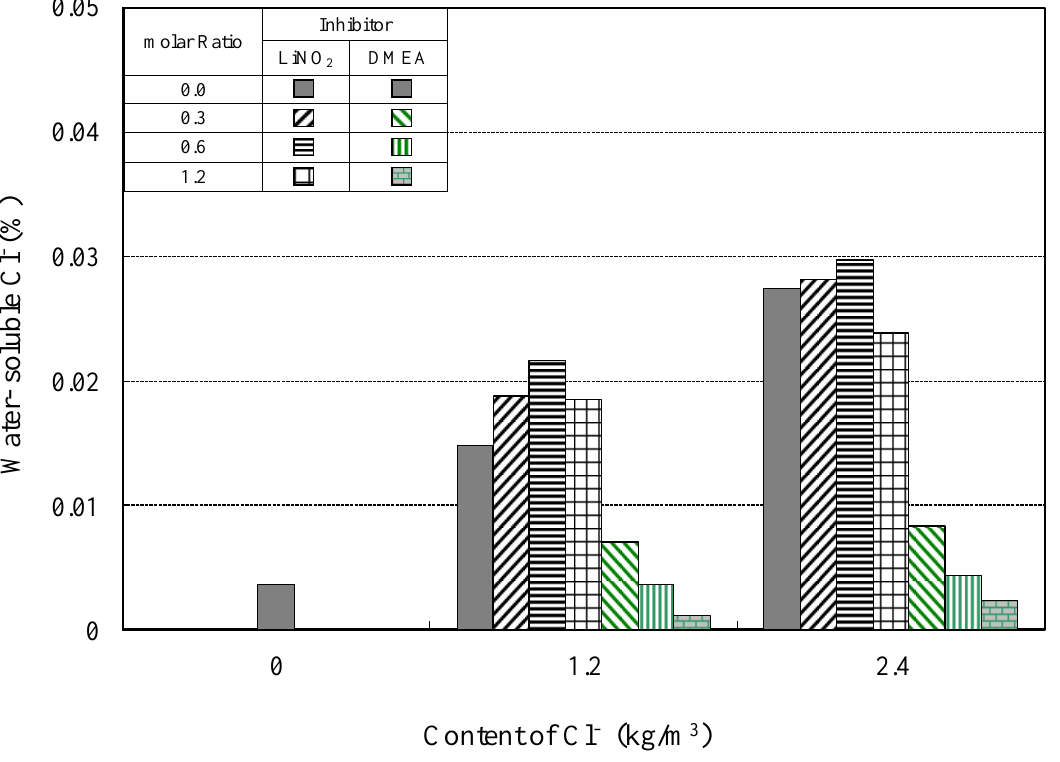
Figure 13. Relationship between water-soluble chloride content and content of Cl − added at different molar ratios of corrosion